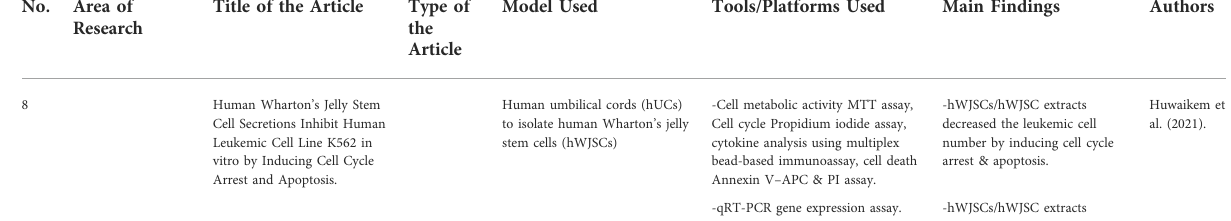
Genomic Tools Applications (RNA-